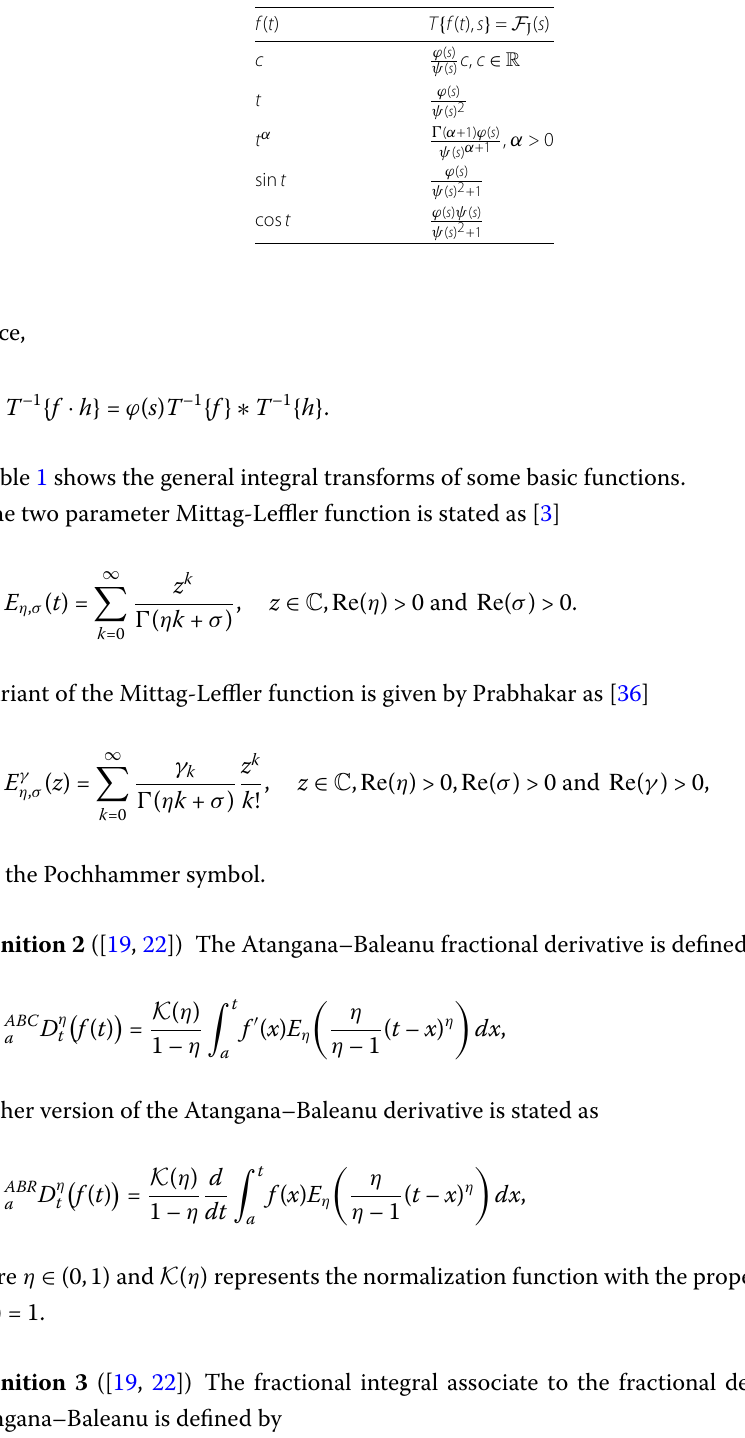
Table 1 Integral transform of some basic functions